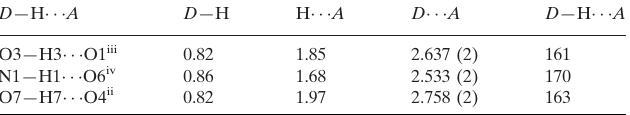
Hydrogen-bond geometry (A˚ , (cid:3)